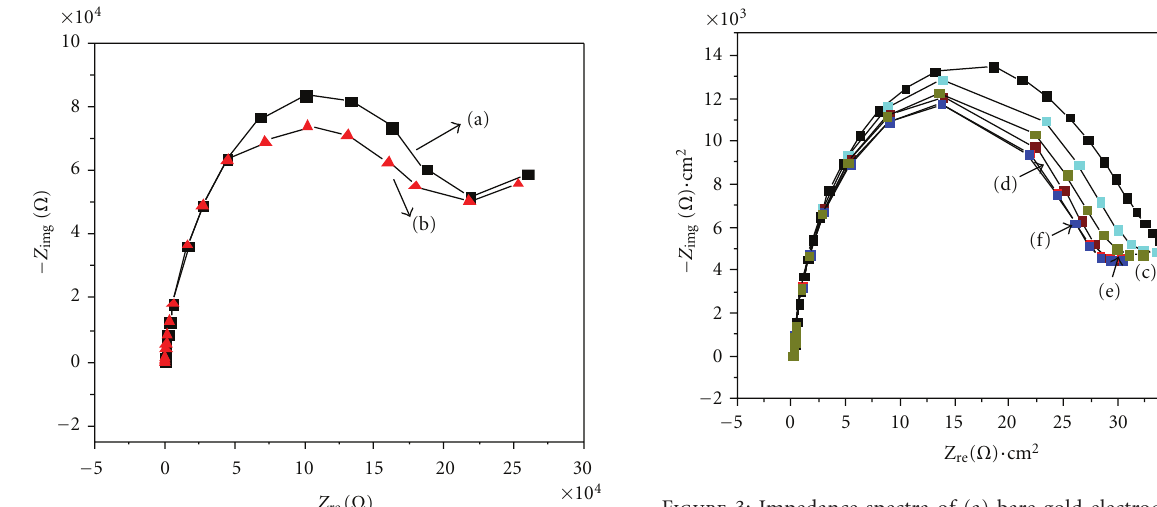
Figure 3: Impedance spectra of (a) bare gold electrode/magnetic beads/polyclonal Ab anti- E. coli ; (b) 10 3 CFU/mL; (c) 10 4 CFU/mL; (d) 10 5 CFU/mL; (e) 10 6 CFU/mL; (f) 10 7 CFU/mL; (f = g) 10 8 CFU/ mL.